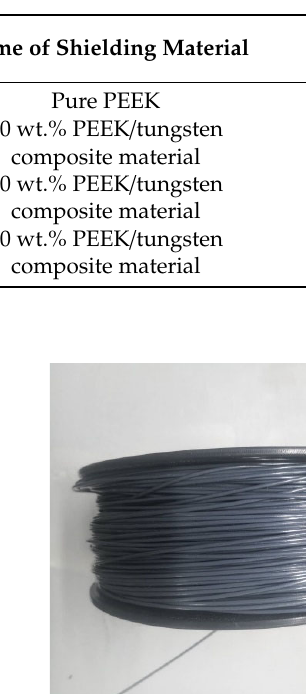
Table 1. Material ratios of PEEK / tungsten composite materials.